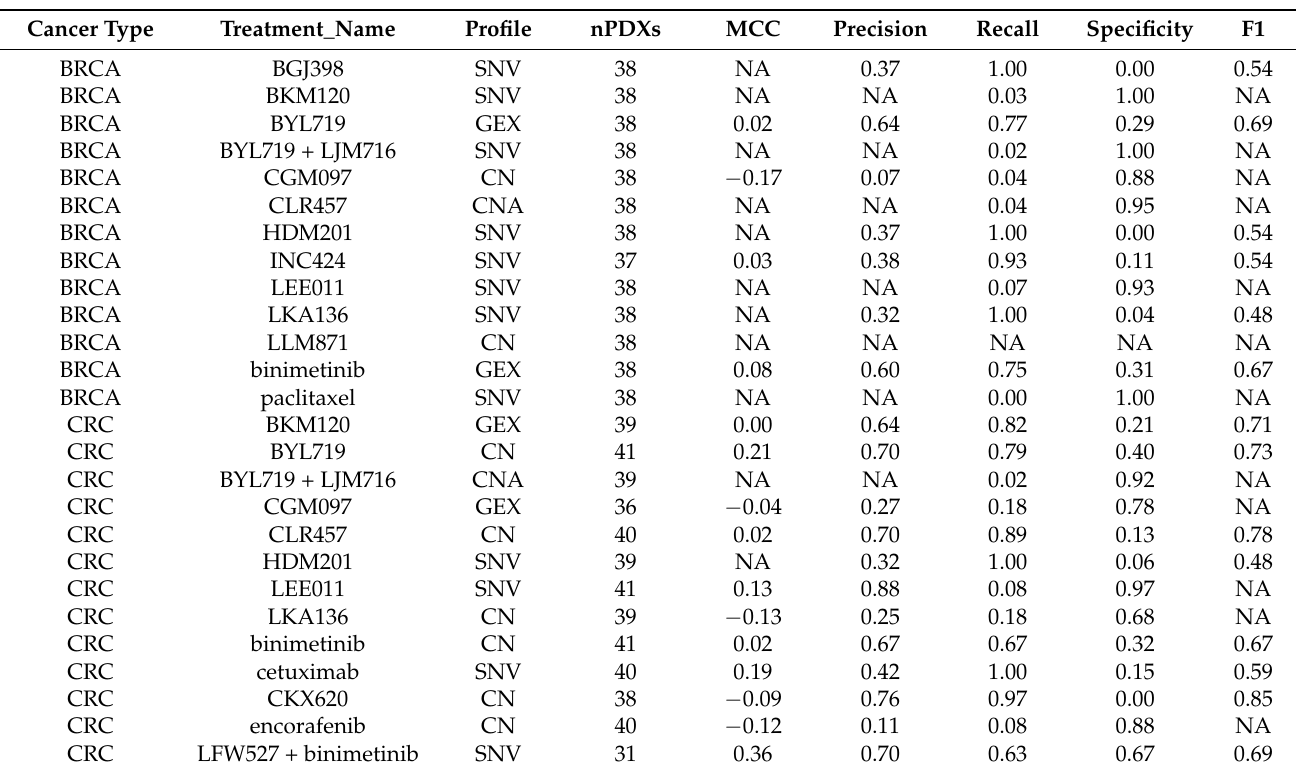
Table 2. RF model using the randomly selected subset of features for the 26 treatment-cancer type pairs. Cancer